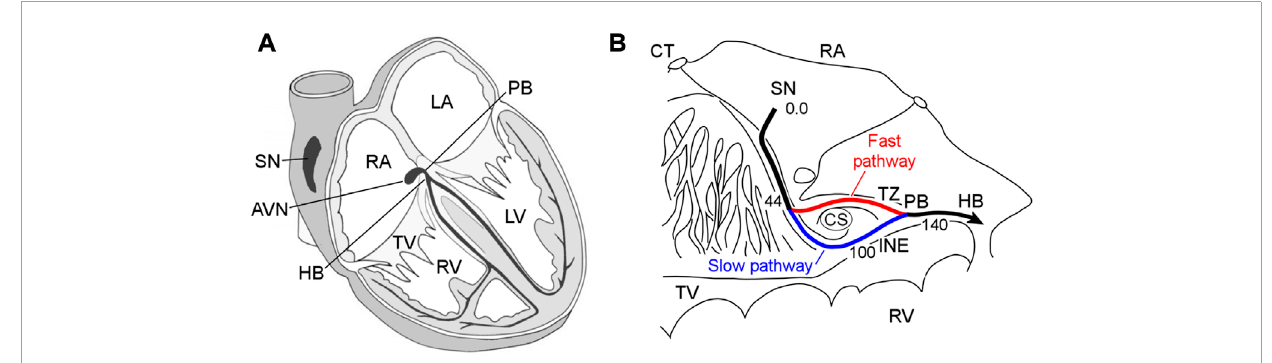
FIGURE 1 (A) Conduction system of the mammalian heart. SN—sinus node, AVN—atrioventricular node, RA and LA—right and left atria, PB—penetrating bundle, HB—His bundle, TV—tricuspid valve, RV and LV—right and left ventricles. (B) Anatomic drawing of the rabbit atrioventricular node and surrounding tissues with excitation wave latency (from (de Carvalho et al., 1959)). CT—crista terminalis, CS—coronary sinus, TZ—transitional zone, and INE—inferior nodal extension. The numbers in milliseconds are given with respect to the sinus node pacemaker. The fast and slow pathways are indicated by red and blue lines,